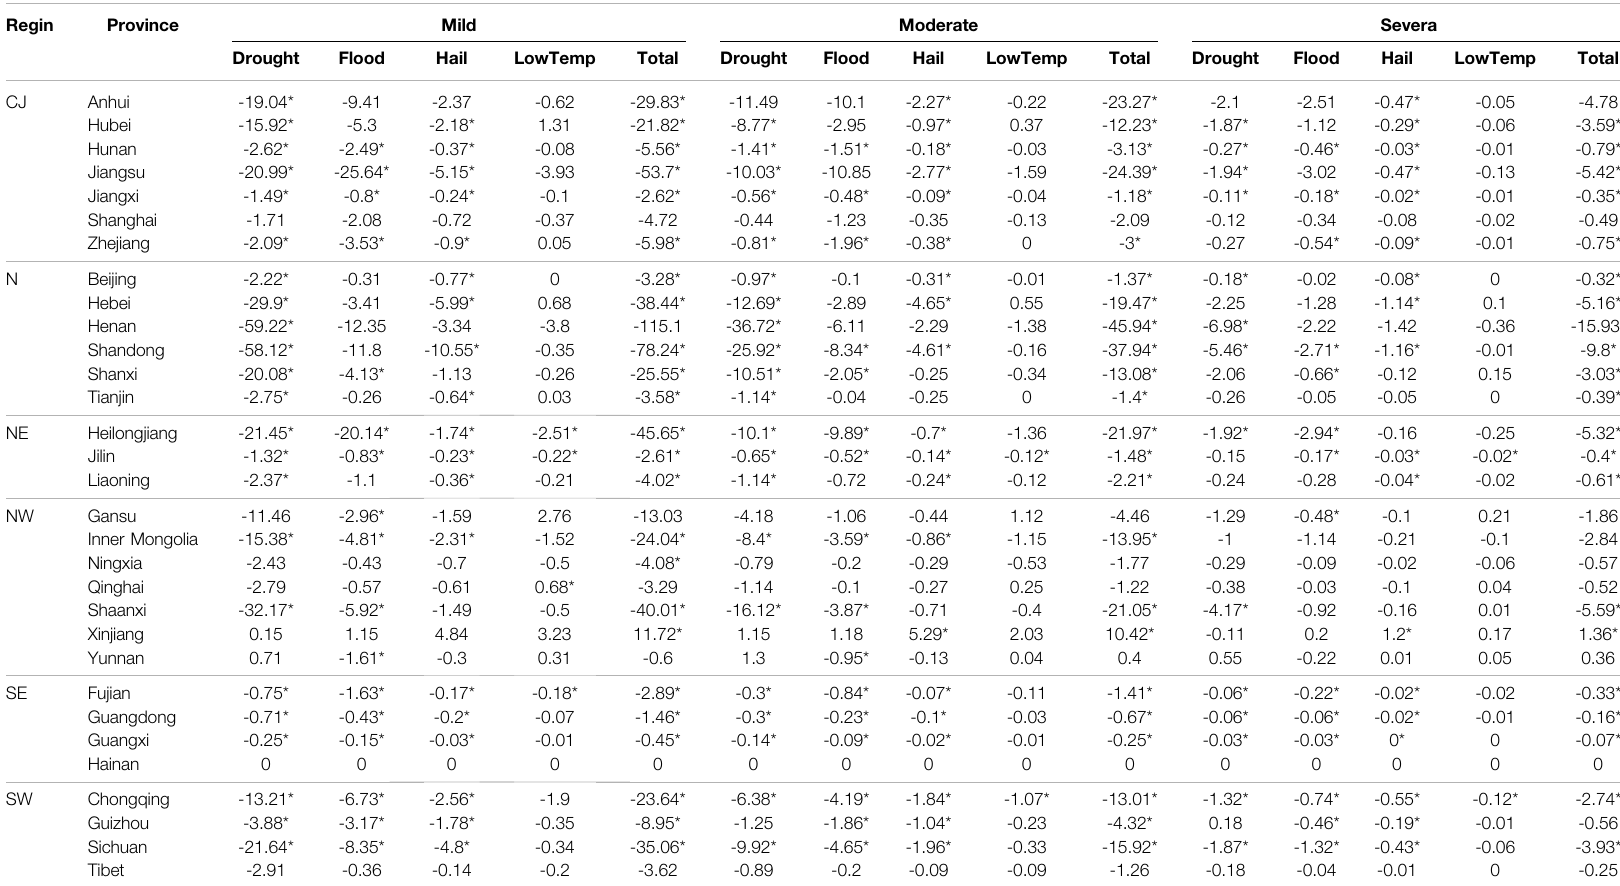
TABLE 3 | Linear changes in the wheat cultivation area affected by different natural disasters from 1988 to 2020. * indicates the presence of statistical signi fi cance (Ps < 0.05). Regin Province